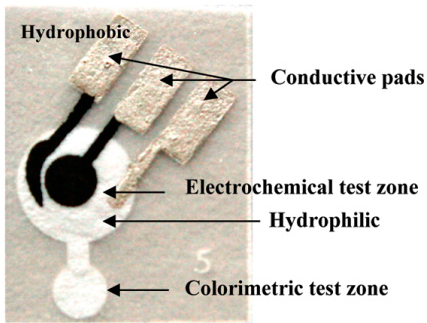
Figure 4. The fabricated Au(III) sensor with a three-electrode electrochemical setup and colorimetric detection zone for determination of Fe(III). Reproduced with permission from [24], Copyright American Chemical Society, 2017.